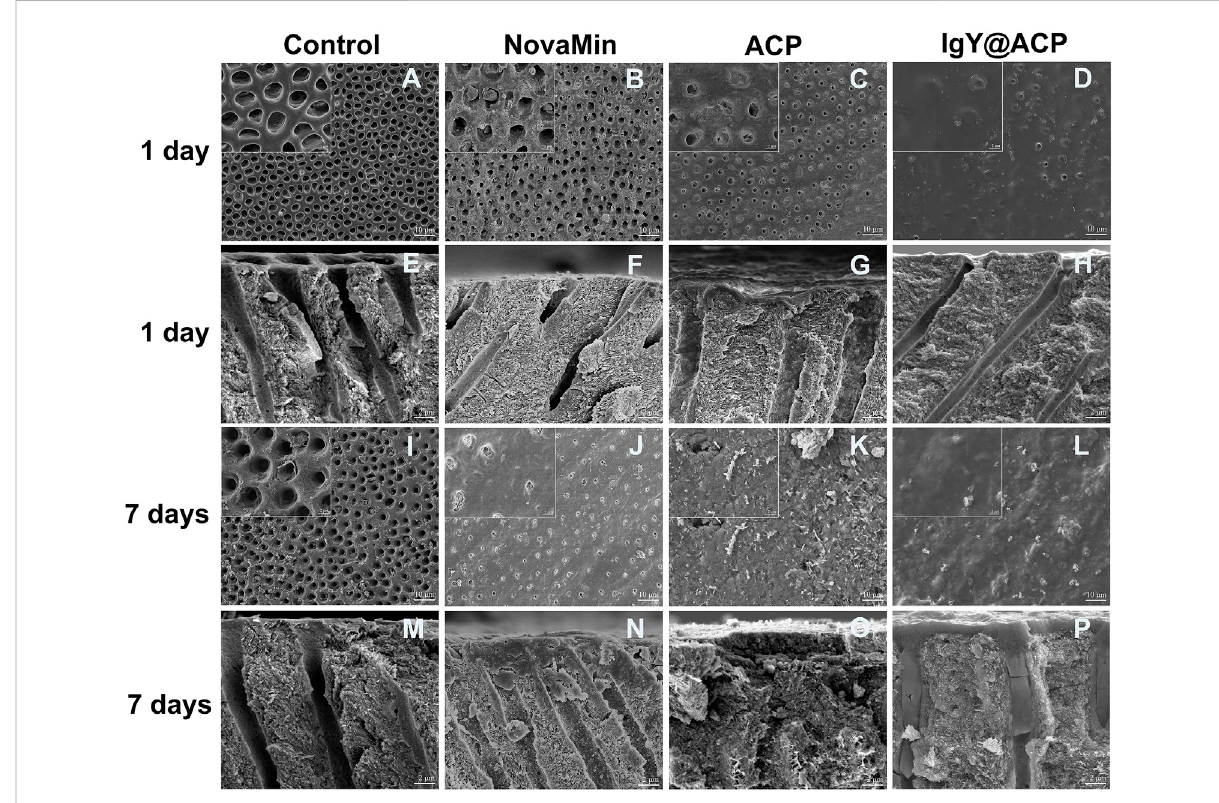
FIGURE 4 SEM micrographs of the surface and cross-section of dentin disks after treatment with NovaMin (B,F) , ACP (C,G) , and IgY@ACP (D,H) for 1 day and treatment with NovaMin (J,N) , ACP (K,O) , andIgY@ACP (L,P) for 7days. Dentin diskswithouttreatment for 1 day (A,E) and 7days (I,M) were used as the control